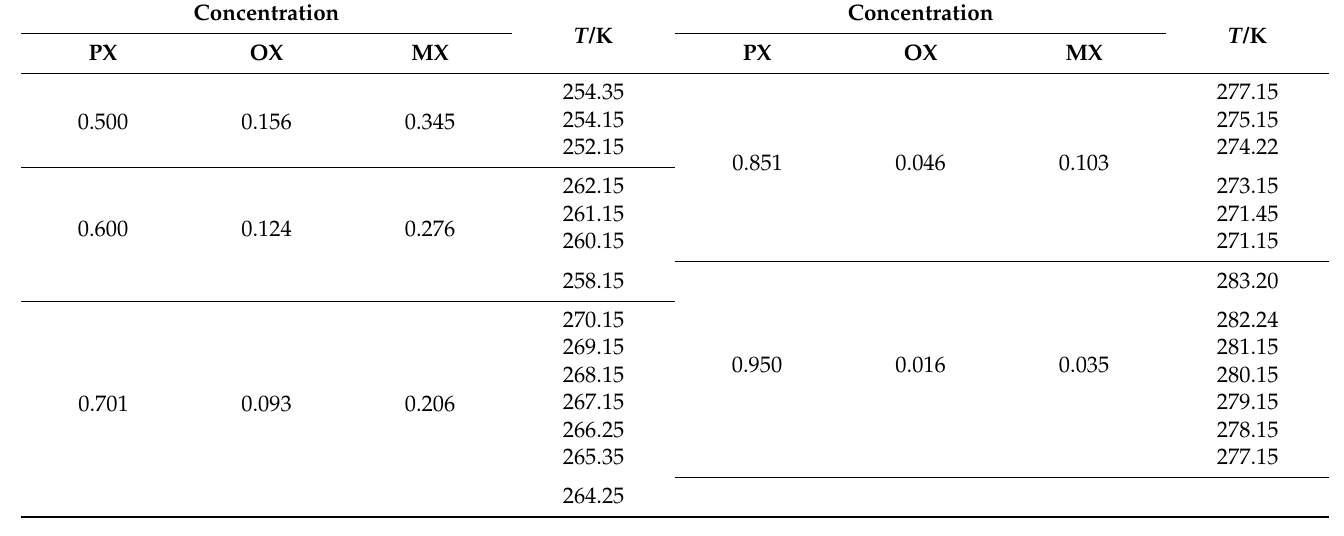
Table 2. The experimental temperatures and concentrations.